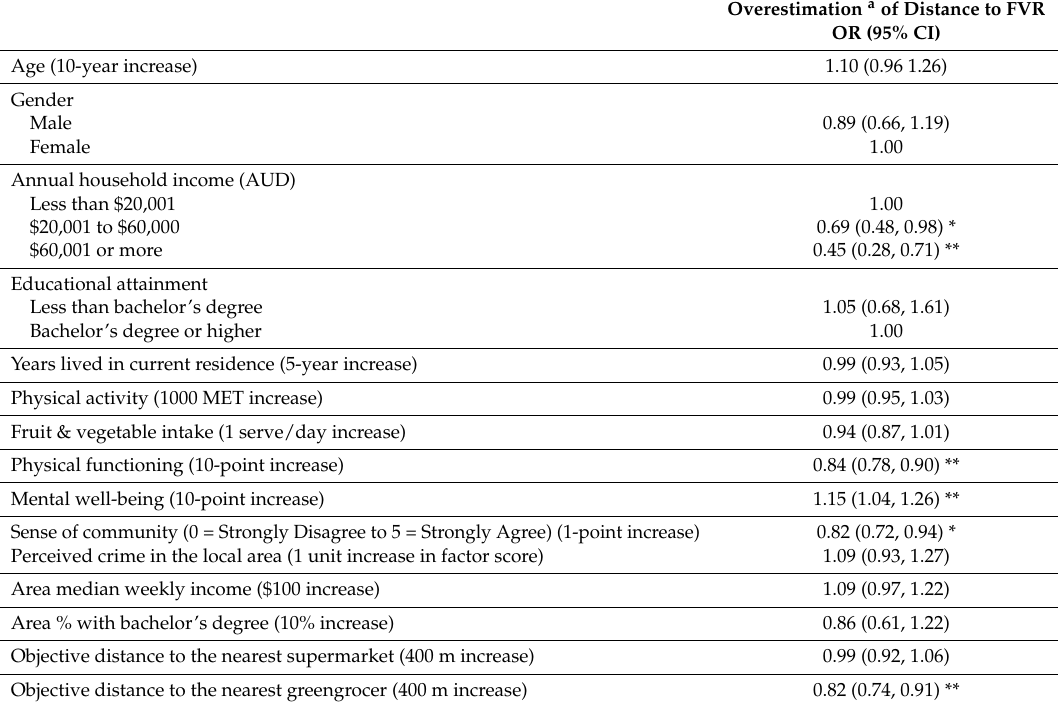
Table 3. Associations between individual and neighbourhood factors and overestimation of distance to FVR ( n =